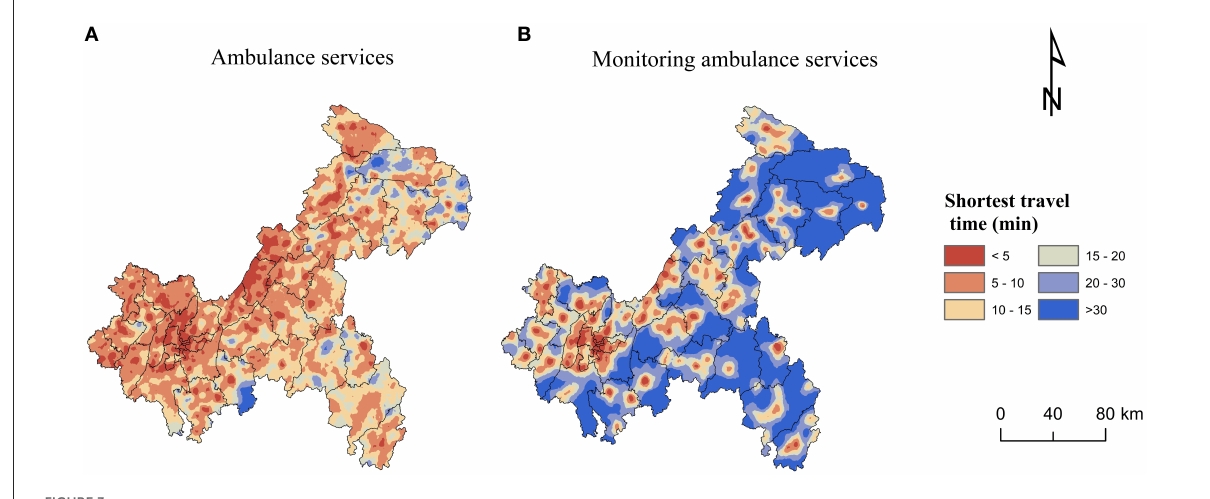
TABLE 4 Distribution of the shortest ravel time to get monitoring ambulance services. Shortest travel Percentage of covered population (communities/villages) at different shortest time (min) Regions